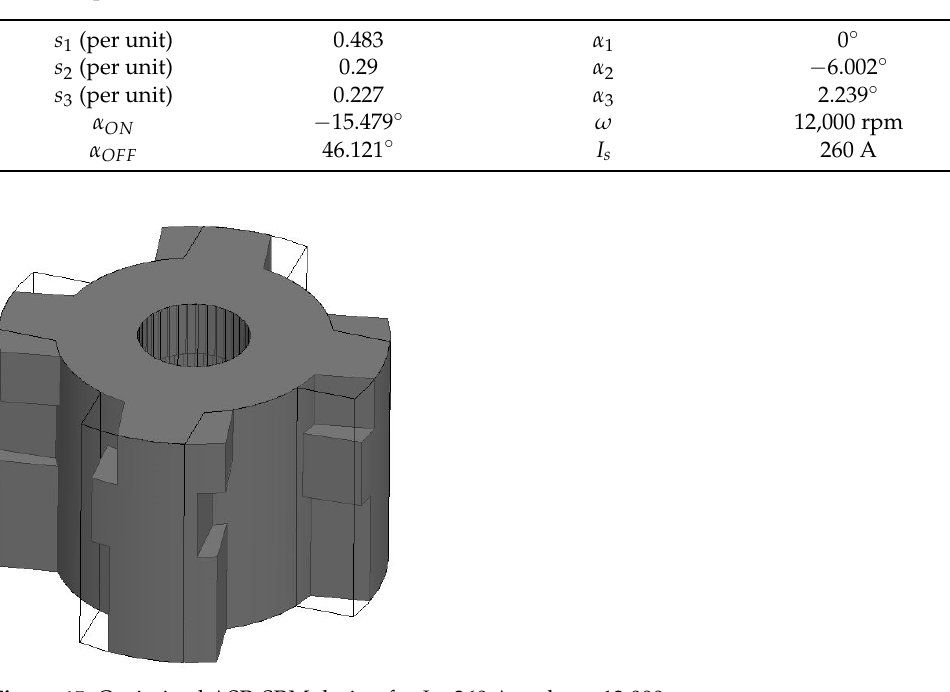
Table 7. Optimization variables for the chosen solution.